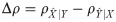
Case II: normally distributed coupling coefficients.(a) The difference between the CCM coefficients, Δρ=ρX^∣Y−ρY^∣X, at L = 500 as a function of the ratio of the averaged coupling coefficients, η¯N/μ¯N. (b) Monte Carlo simulation of 1000 independent realizations of Eq (11) to calculate Δρ at L = 500 as a function of η¯N/μ¯N. η¯N and μ¯N are the mean values of η
N and μ
N over the span of the time–series. Δρ = 0 and η¯N/μ¯N=1 are shown by dashed, bold lines.